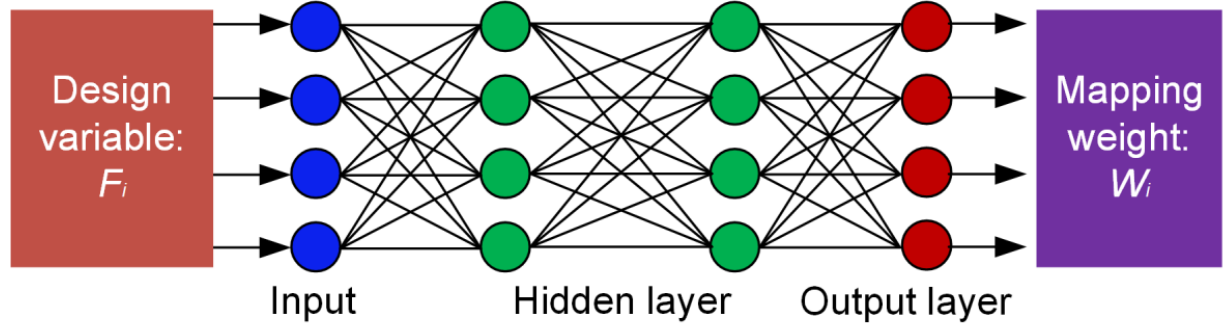
Figure 4. The online prediction realization using the neural network.